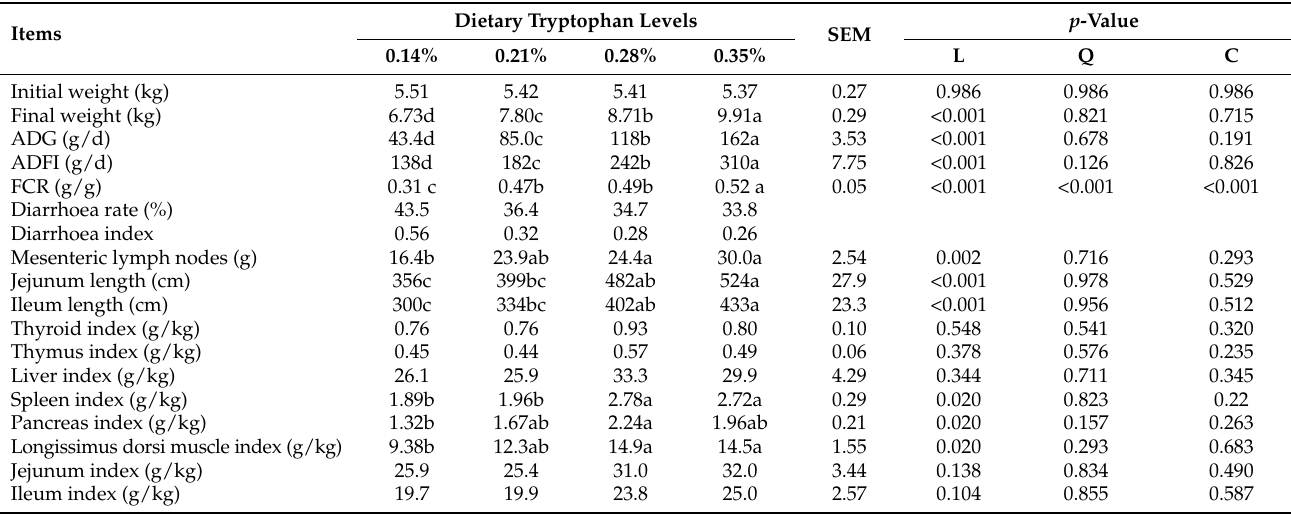
Table 3. Effects of dietary tryptophan levels on growth performance and the morphological development of organs and tissues of weaned piglets.